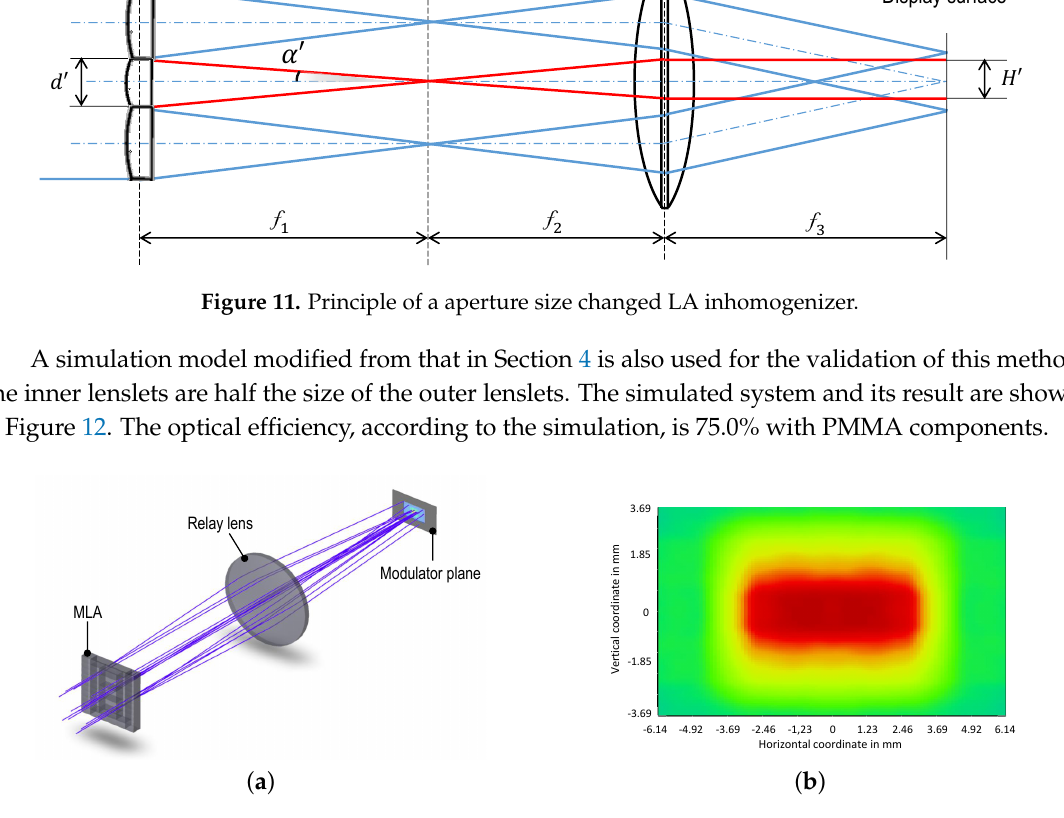
Figure 12. Simulation model and its result for the hotspot generation based on the modification of lenslet dimension. ( a ) Simulation model; ( b ) Detector view located at the modulator